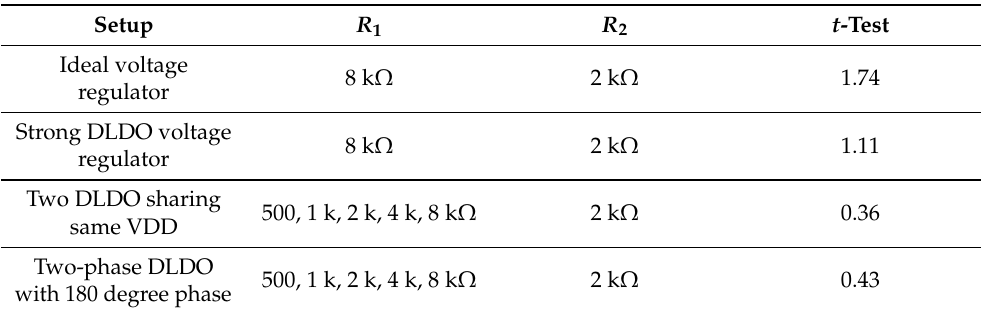
Table 1. Summary of the minimum information leakage results evaluated by a t -test for different voltage regulator and PDN design